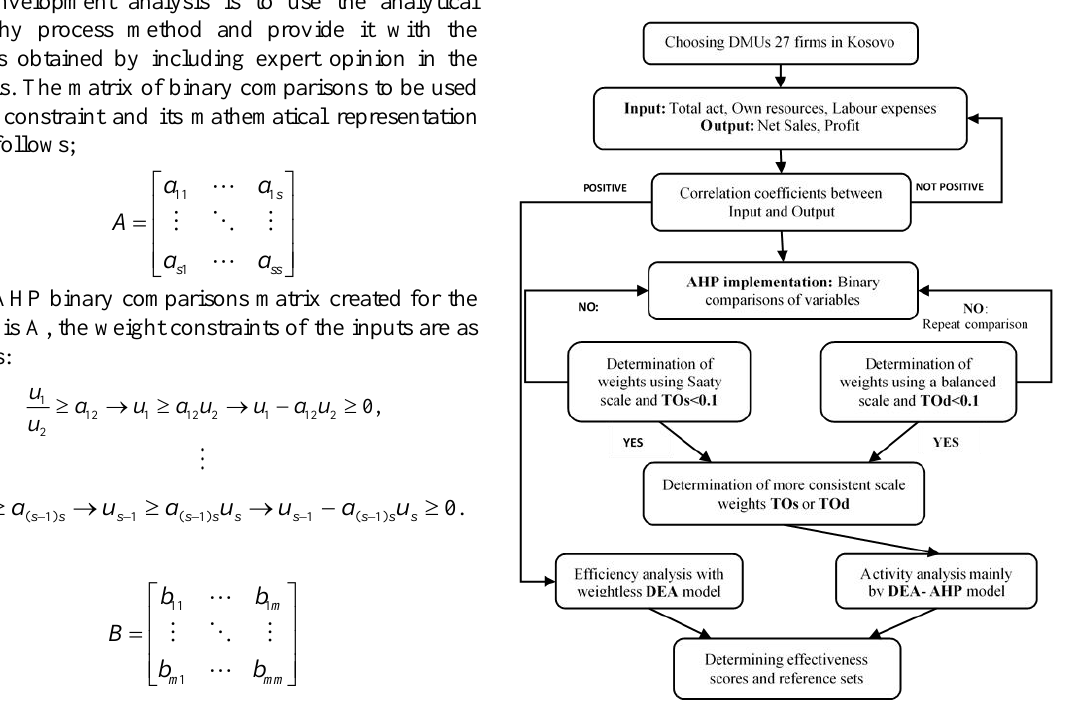
Figure 1 . DEAHP method algorithm flow